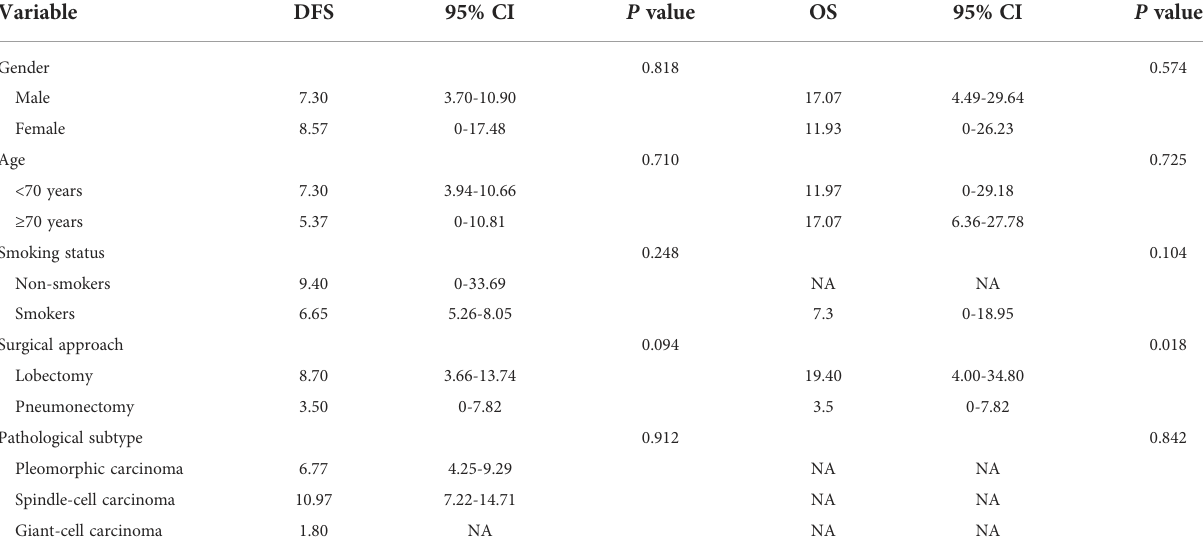
TABLE 6 Univariate analysis of DFS and OS of